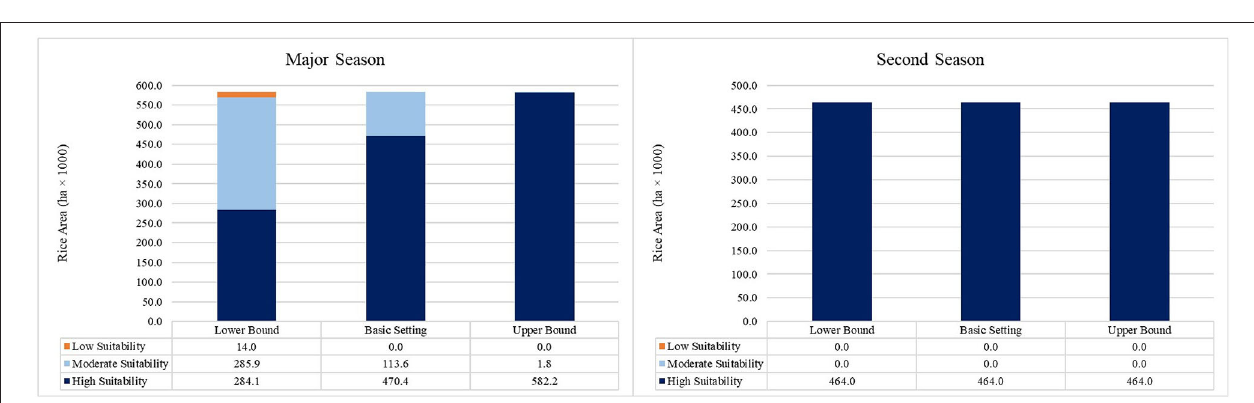
FIGURE 8 | Sensitivity analyses on the settings of potential soil percolation rates (Pot_Pc) in the major and second rice seasons (the case for breakpoint